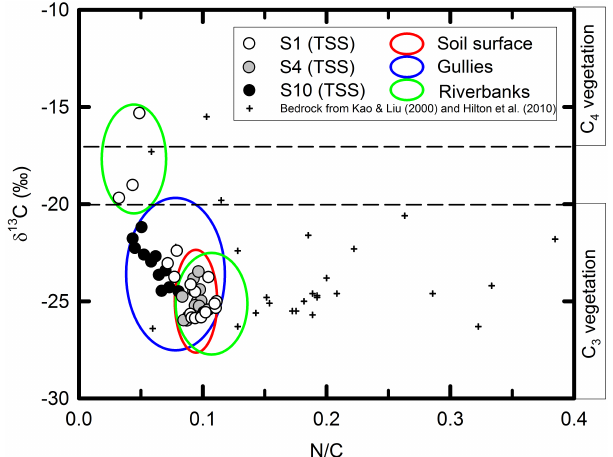
Figure 6. Plot of δ 13 C vs. TN / TOC for total suspended sediment loads (TSS) collected at S1 (open circles), S4 (grey circles) and S10 (closed circles) during the 23 May 2012 flood and for the poten- tial sources of sediment (Soil surface: red area; Gullies: blue area; Riverbanks: green areas) determined in the catchment. Bedrock data (plus signs) are taken from the literature (Kao and Liu, 2000; Hilton et al.,